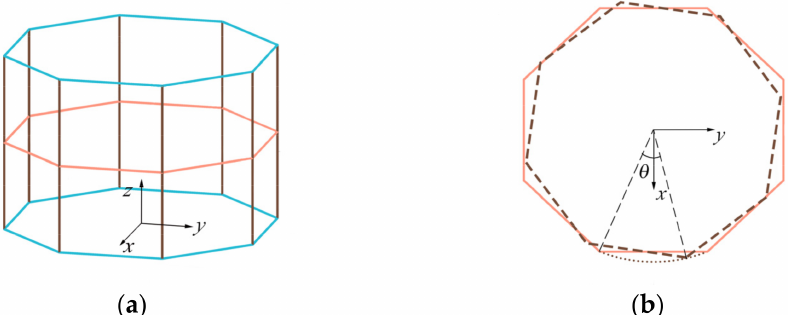
Figure 4. The geometric model of the axial motion of a two-layer twisted tower: ( a ) the skeleton model of a two-layer twisted tower; ( b ) the trajectory of the apex with axial motion in top view. There is an offset angle α between the link and bottom plates. The definition of